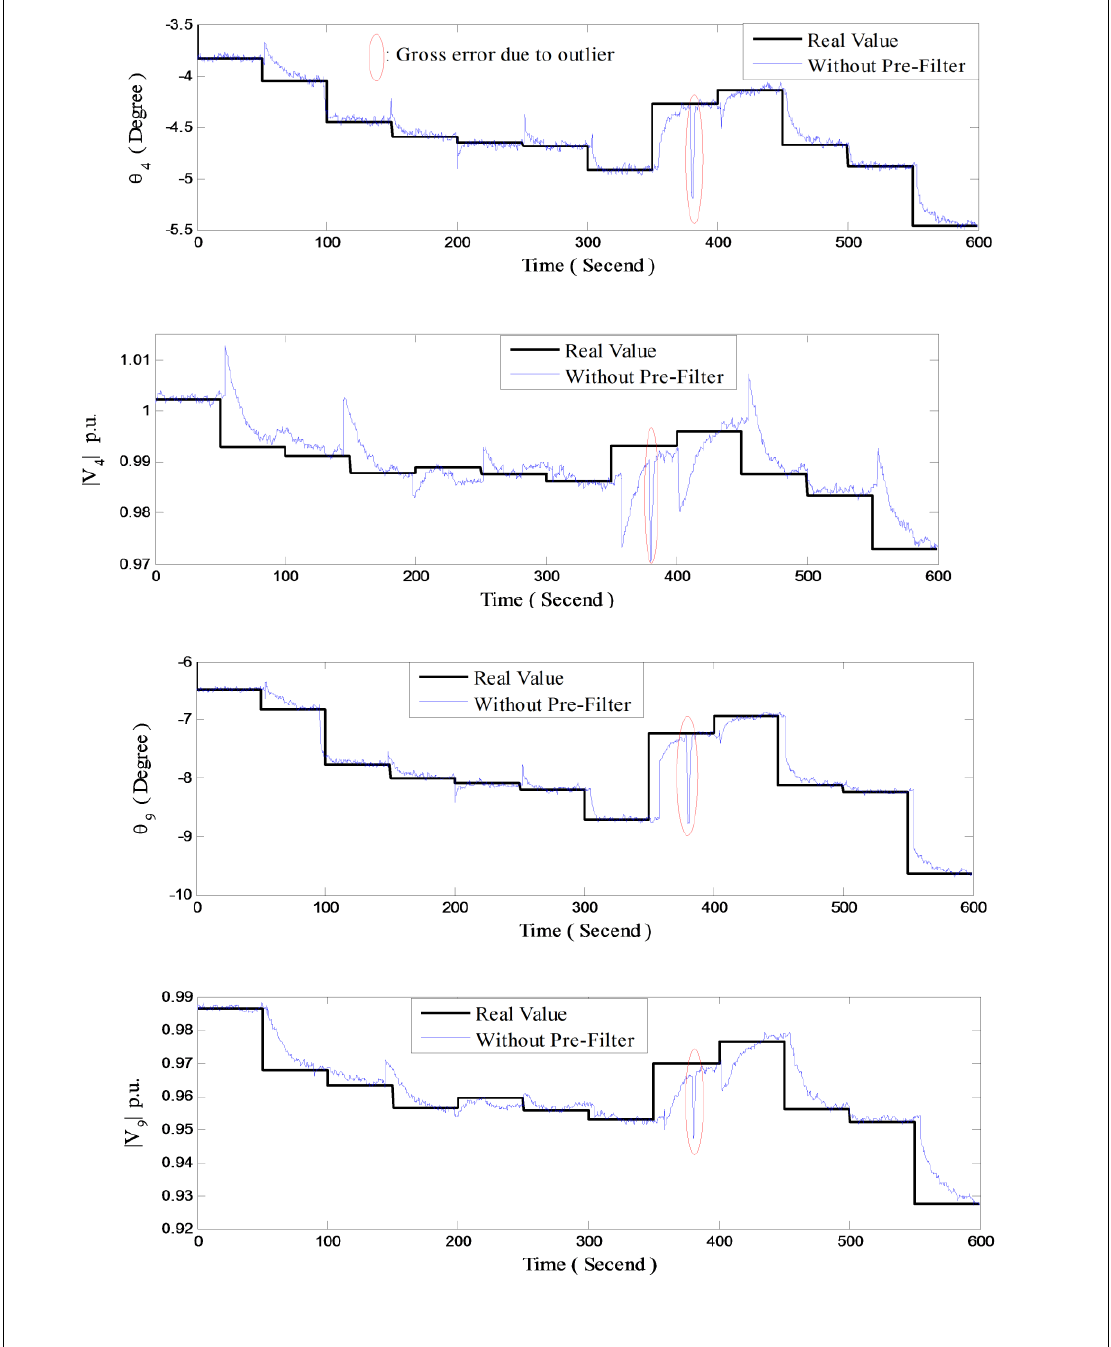
Figure 9. Some state estimation results without